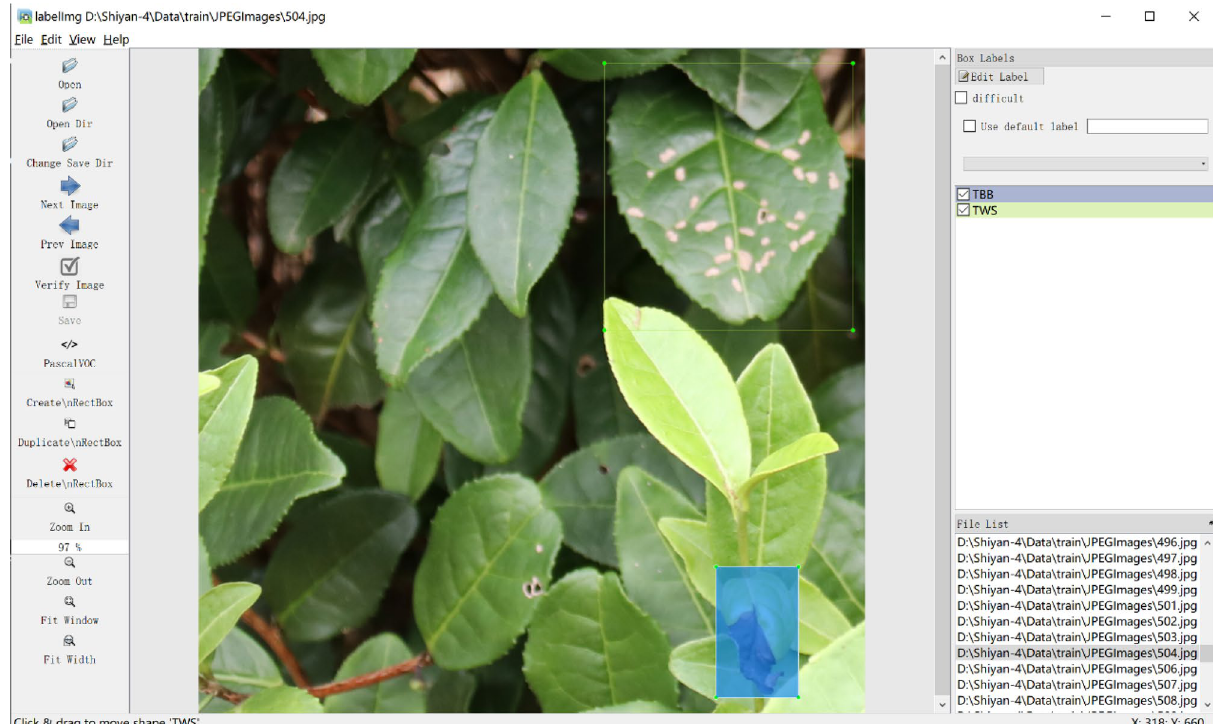
Figure 3. Using LabelImg tool to annotate tea leaf diseases and their